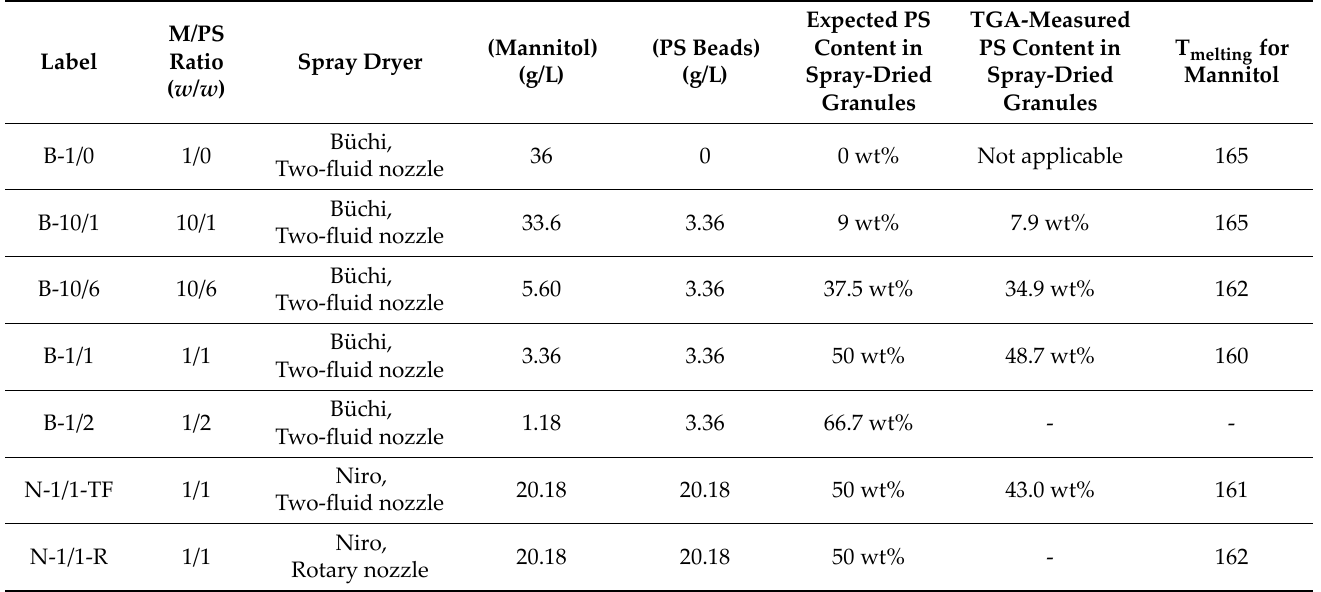
Table 1. Overview of the M/PS granules obtained with different sets of synthesis conditions (M = mannitol, PS = polystyrene